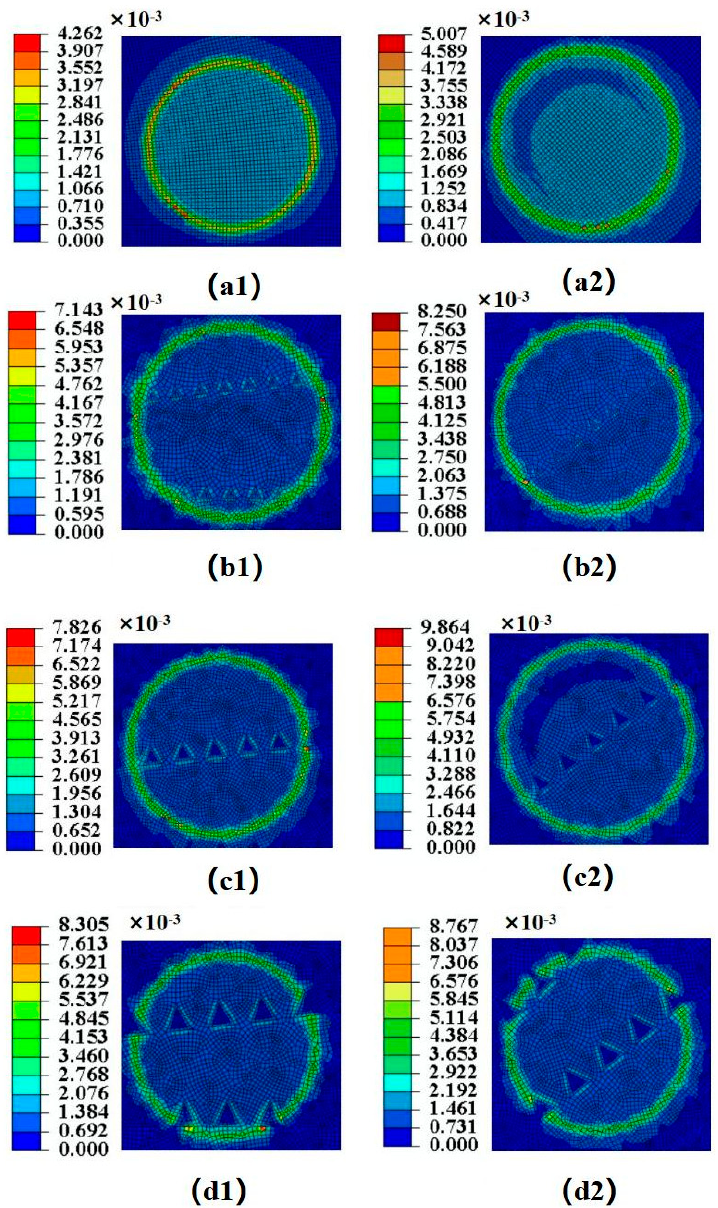
Figure 16. Untextured and textured surface stress distribution cloud map at 0 s and 0.05 s (GPa). ( a1 ) Ar 0-0 S, ( a2 ) Ar 0-0.05 S, ( b1 ) Ar 11.45%-0 S, ( b2 ) Ar 11.45%-0.05 S, ( c1 ) Ar 23.86%-0 S, ( c2 ) Ar 23.86%-0.05 S, ( d1 ) Ar 38.95%-0 S, ( d2 ) Ar 38.95%-0.05 S.